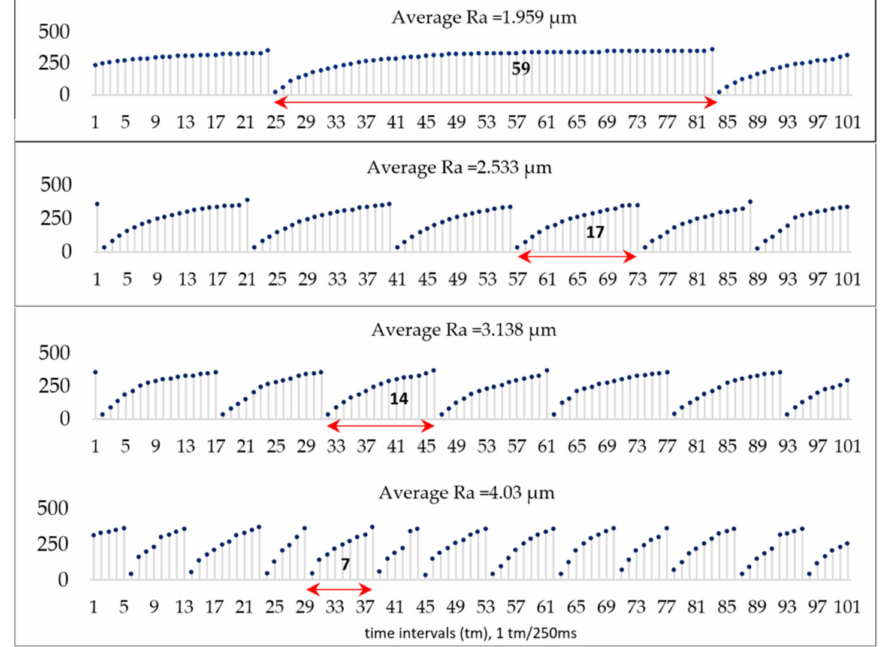
Figure 18. Capacitor charge cycle duration dependence on the surface roughness of the workpiece: 14.759 s vs. Ra = 1.959 µ m, 4.25 s vs. Ra = 2.533 µ m, 3.25 seconds vs. Ra = 3.138 µ m, 1.75 seconds vs. Ra = 4.03 µ m.